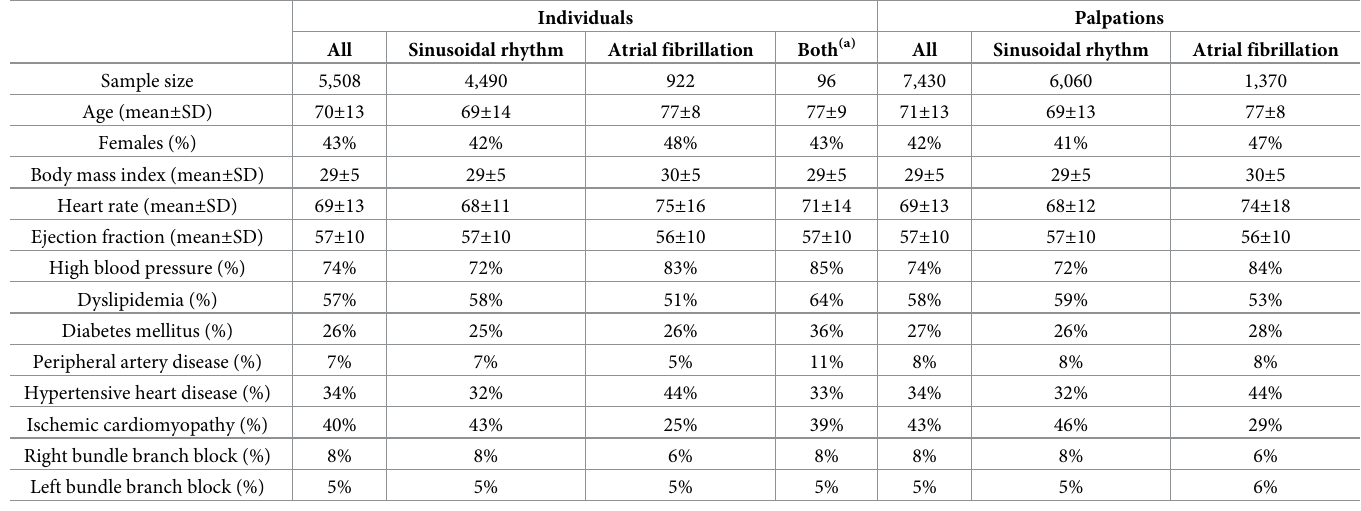
Table 1. Description of the sample.